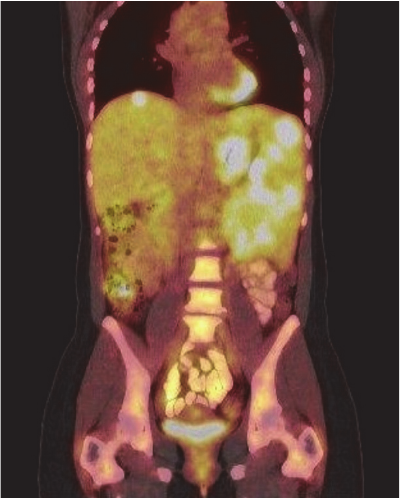
Figure 1: Preoperative PET-CT scan revealed multiple nodules in the spleen and a hepatic lesion with high metabolic activity.